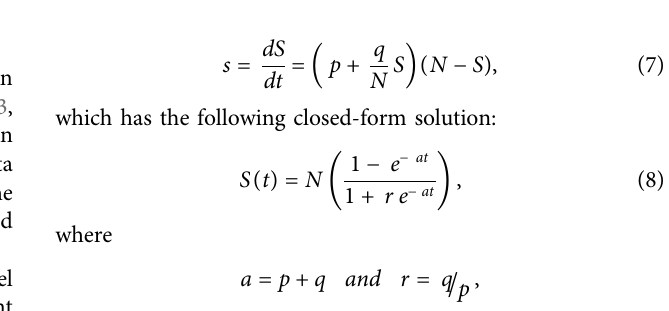
Frontiers in Applied Mathematics and Statistics |